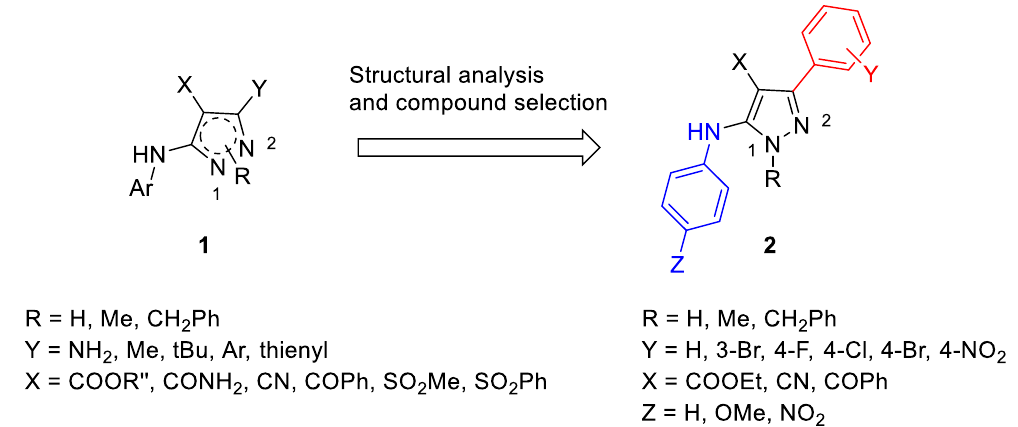
Figure 2. General structure of previously synthesized pyrazoles 1 and 2. The 3-phenyl and the 5-anilino- substituents are colored red and blue, respectively.